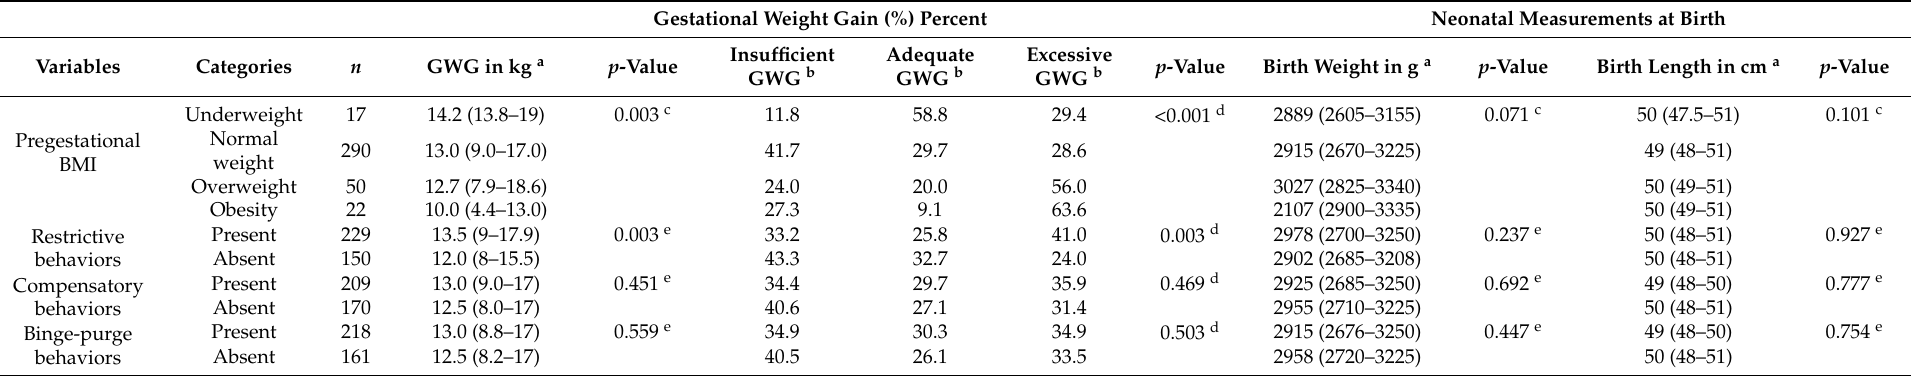
Table 3. Maternal gestational weight gain and neonatal birth weight and length according to maternal pregestational BMI and factors of disordered eating behaviors.